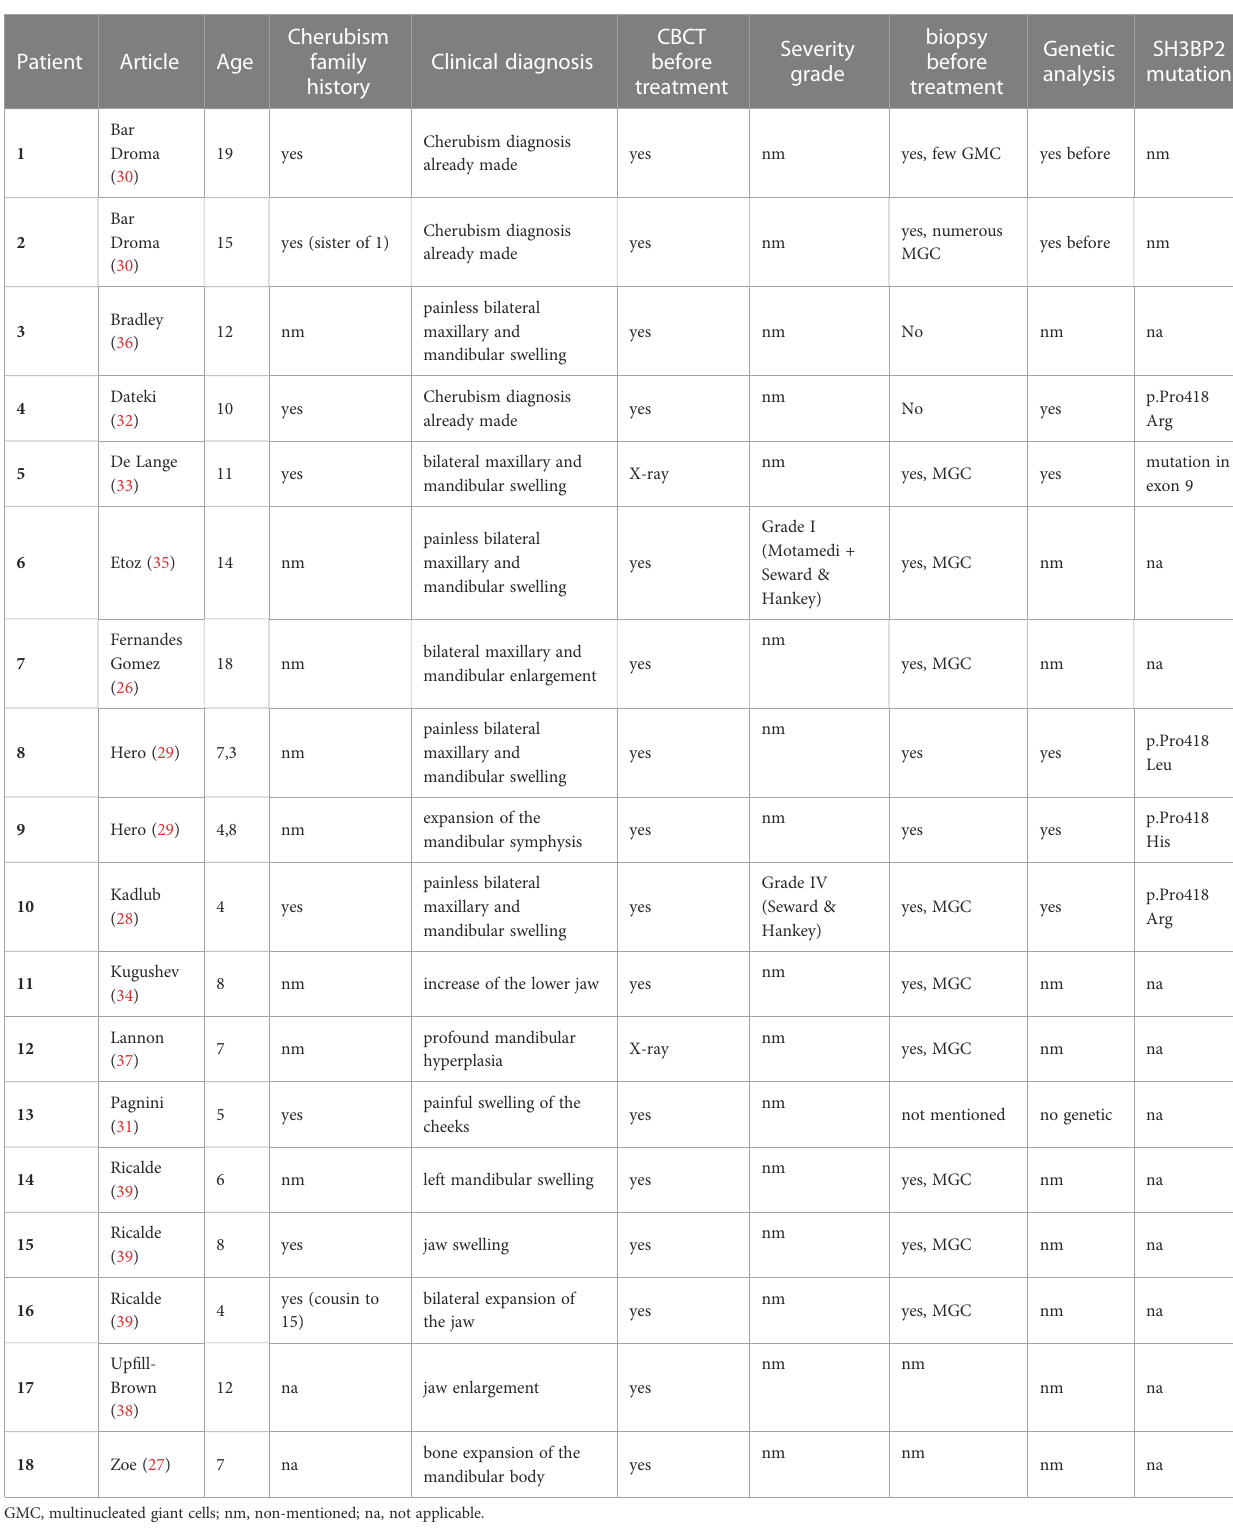
TABLE 3 Cherubism diagnostic